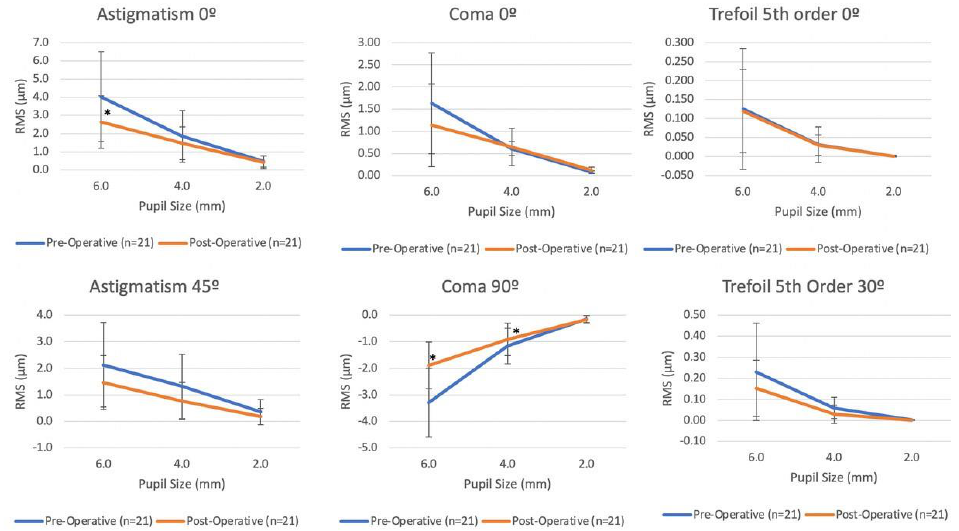
the variants had a statistically significant reduction in a 2 mm pupil. (Figure 1).